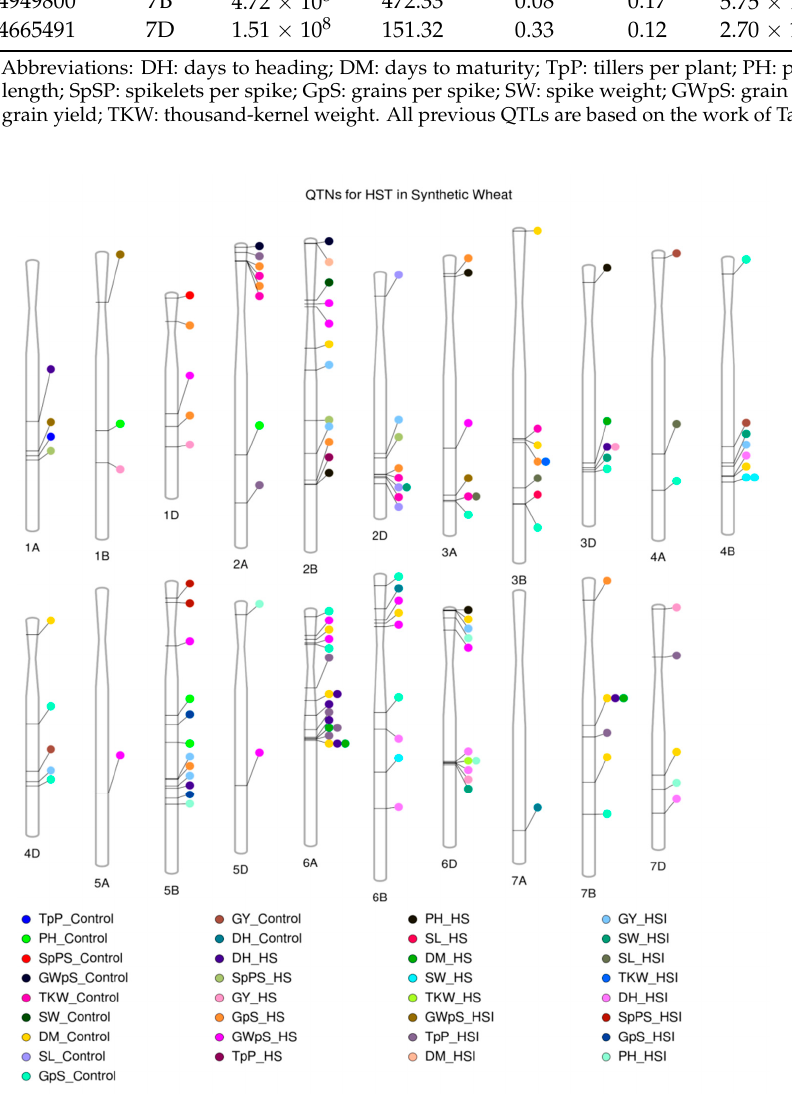
Figure 2. Location of QTNs identified on the chromosome. Abbreviations: DH: days to heading; DM: days to maturity; TpP: tillers per plant; PH: plant height; SL: spike length; SpSP: spikelets per spike; GpS: grains per spike; SW: spike weight; GWpS: grain weight per spike; GY: grain yield; TKW: thousand-kernel weight; HS: heat stress.